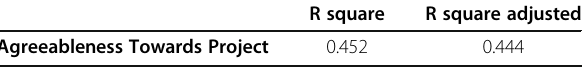
Table 12 Coefficient of determination